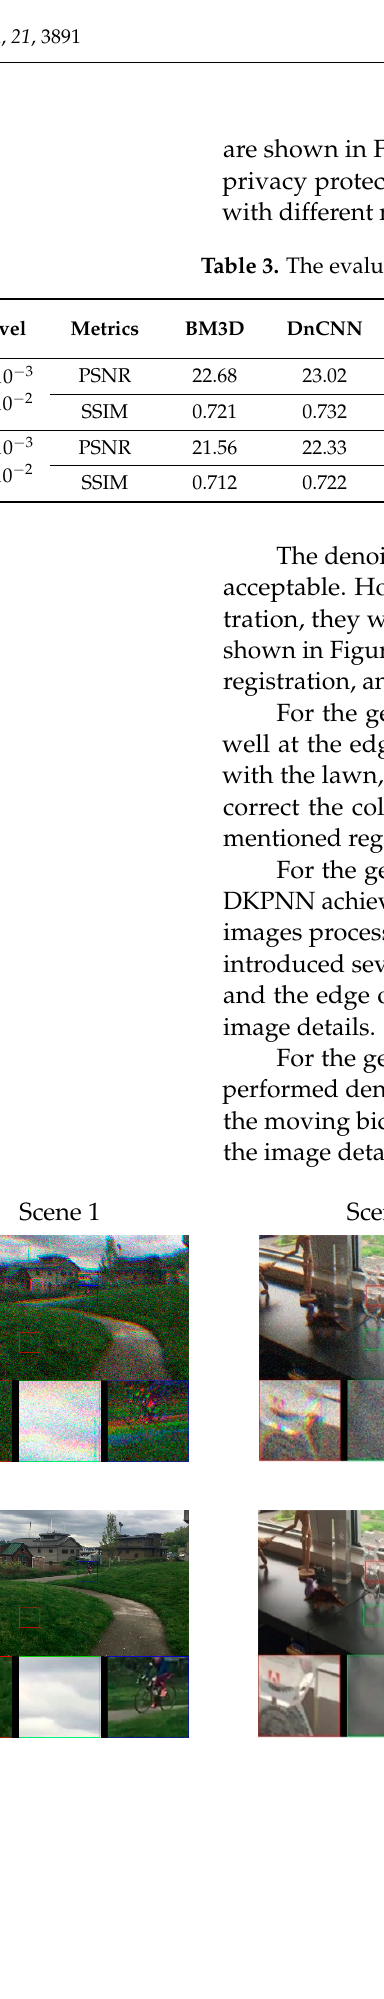
Table 3. The evaluation metrics on the test set data for each algorithm.